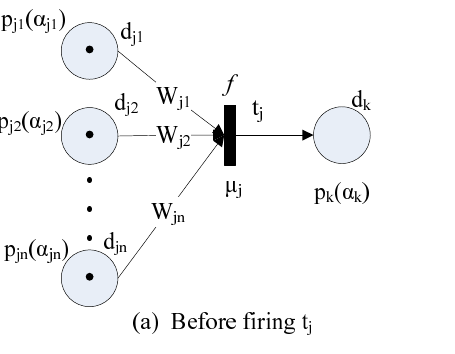
Figure 2. Fuzzy Petri nets representation of type 1